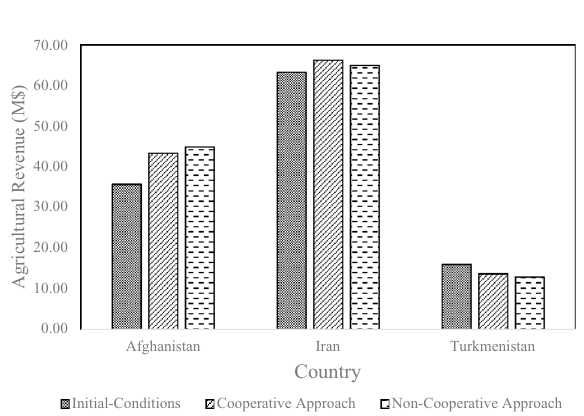
Figure 6. Total annual revenue calculated with the three allocation approaches (M$ = 10 6 $).